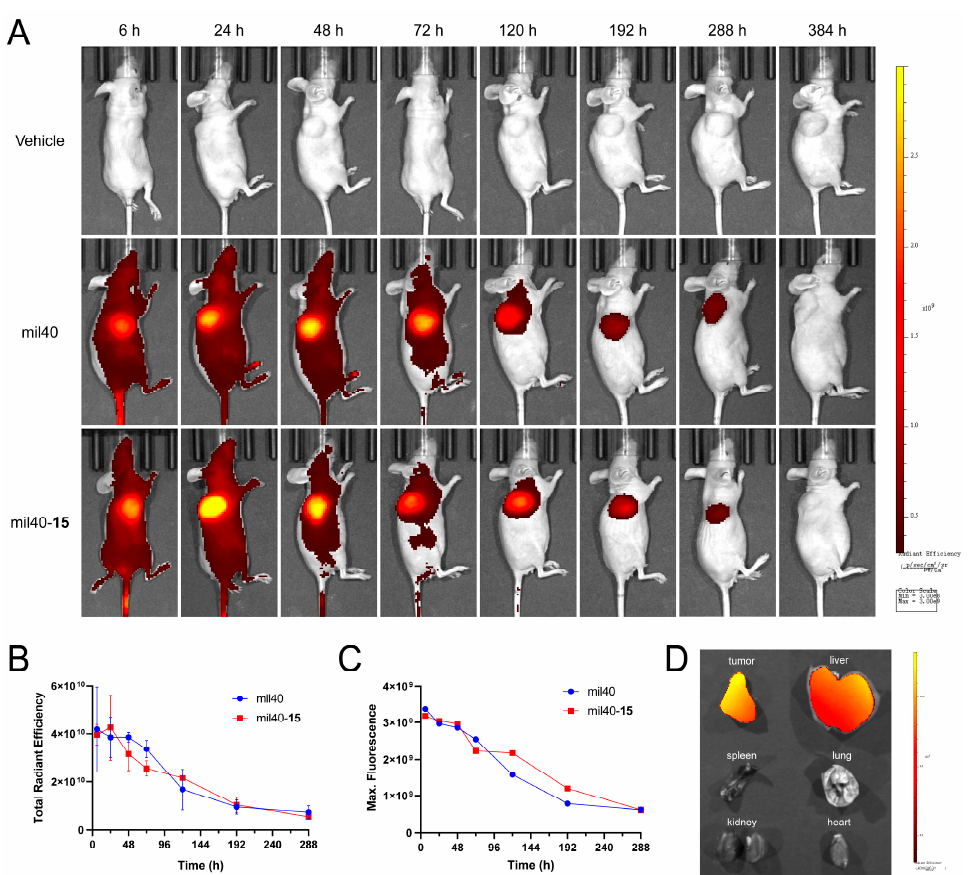
Figure 7. Fluorescence imaging of the Cys-linker-MMAE-based ADC in NCI-N87 xenograft model. ( A ) In vivo imaging of fluorescein-labeled ADC, color scale represents photons / s / cm 2 / steradian. ( B ) The total radiant efficiency of test mice in NCI-N87 xenograft model; the results are shown as the mean ± SD, n = 3 / group. ( C ) The maximum fluorescence of test mice in NCI-N87 xenograft model. ( D ) In vitro fluorescence imaging of mouse tissues in ADC administration group.